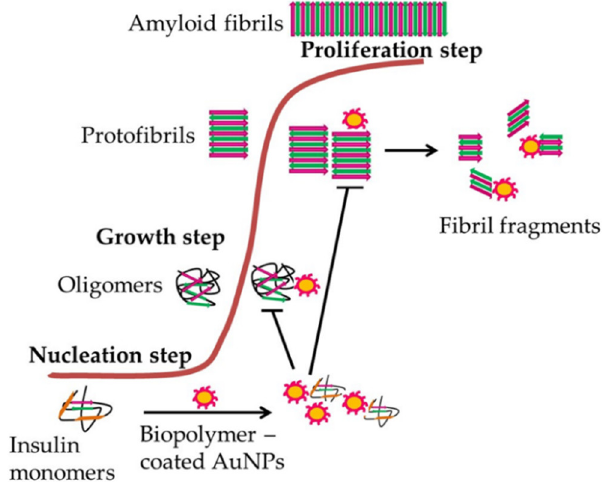
Figure 1. Interaction mechanism of biopolymer-coated AuNPs mediated inhibition of insulin amyloid fibrillation. The formation of amyloid fibrils is a multi-step process. Interaction of biopolymer-coated AuNPs with insulin monomers during the nucleation step of fibrillation inhibits the insulin amyloid fibril formation. These ENPs strongly interact with insulin monomers via their –OH and –NH 2 groups thereby, inhibiting oligomer formation and protofibril elongation resulting in the formation of thin and short fibrils.